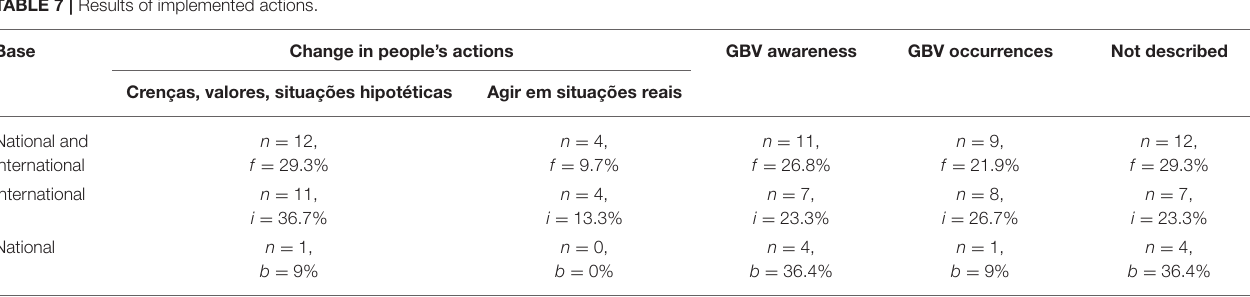
TABLE 7 | Results of implemented